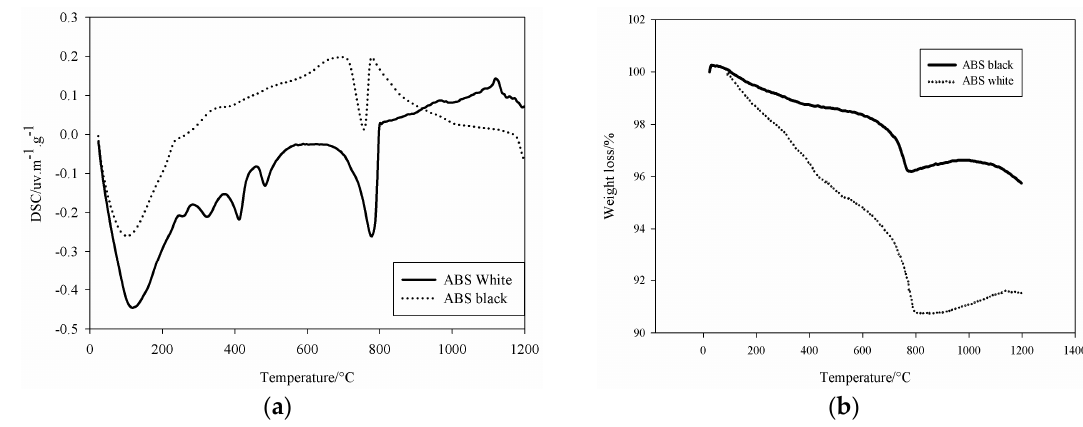
Figure 2. Thermal characterization of the starting two steel slags used for this study: ( a ) DSC curve and ( b ) TGA analyses.